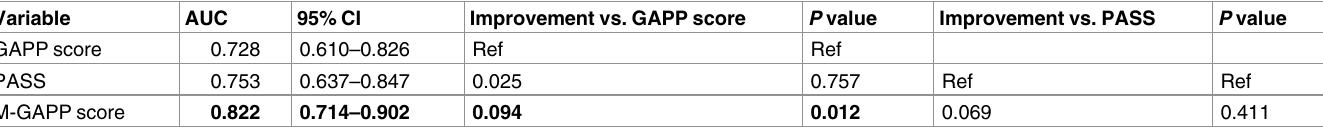
Table 7. Receiver-operating characteristic analysesof three scoring systemsfor predicting metastatic potential in pheochromocytoma and paraganglioma. Variable Improvement vs. GAPP score Improvement vs.